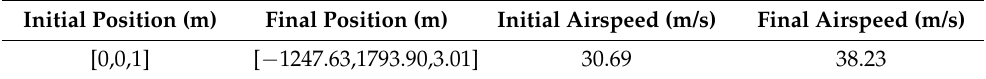
Table 3. Trajectory Figure 17. The energy change calculated by the energy harvesting mechanism.